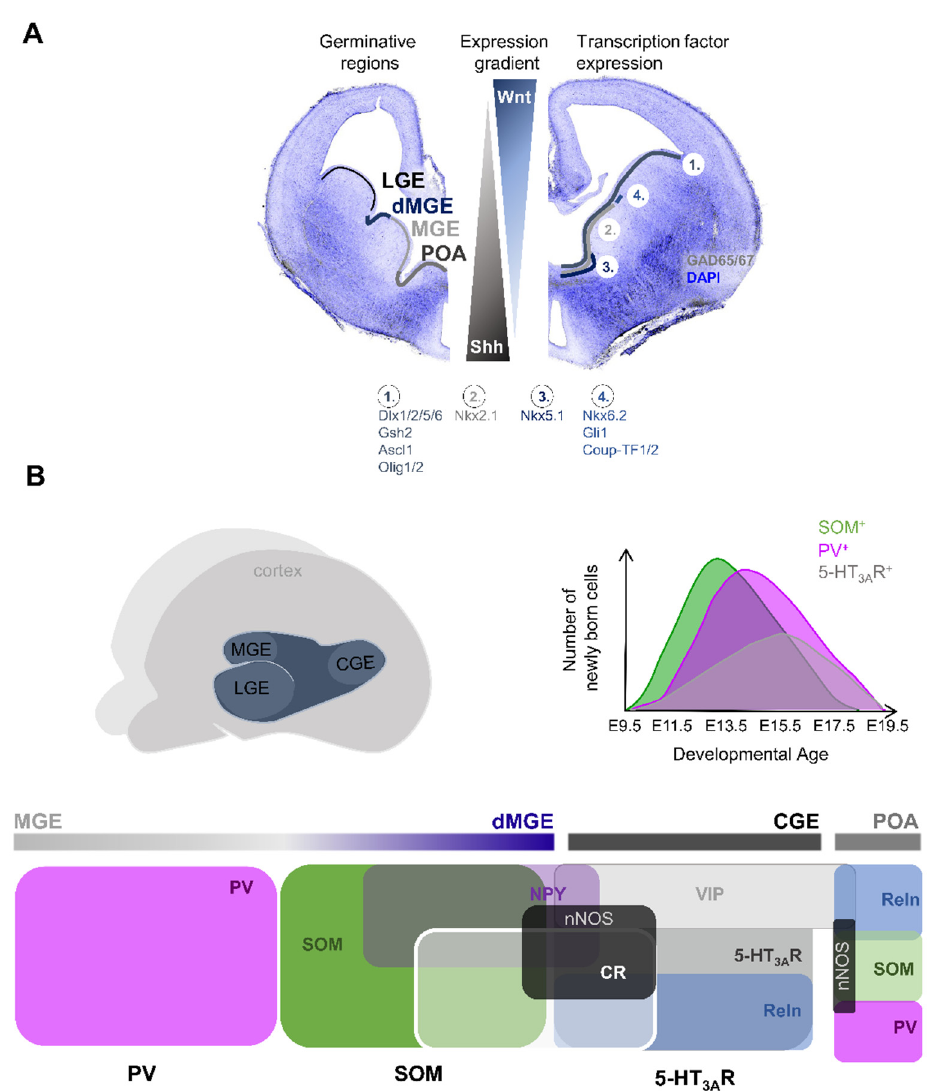
Figure 3. Embryonic origin and development of cortical interneurons. ( A ) Confocal image of a E14.5 coronal brain slice stained for GAD65/67 (grey) and DAPI (blue). The germinative regions (LGE, dMGE, MGE, and POA) are illustrated on the left hemisphere. The expression of distinct transcription factors is illustrated on the right hemisphere. The graded expression of Shh and Wnt is depicted in the middle. ( B ) Top, left panel: schematic representation of the brain with germinative regions illustrated in dark blue; and right panel: diagram showing the generation of SOM + , PV + , and 5-HT3AR + INs as a function of developmental age. Bottom: schematic of germinative regions in the embryonic brain and their relative contribution to classes of INs. The MGE gives preferentially rise to PV + and SOM + INs, whereas the CGE primarily produces 5-HT 3A R + INs. The POA in turn produces a mixed population of GABAergic INs. MGE and CGE-derived INs typically coexpress a combination of different neurochemical markers, some of which are illustrated.